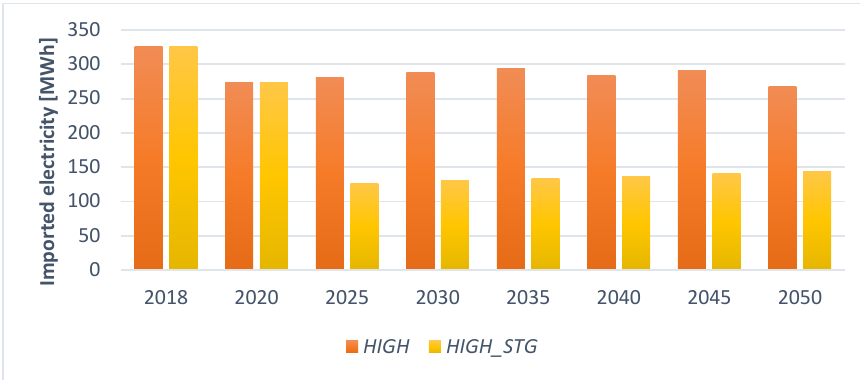
Figure 13. Effect of storage on public sector electricity imports.